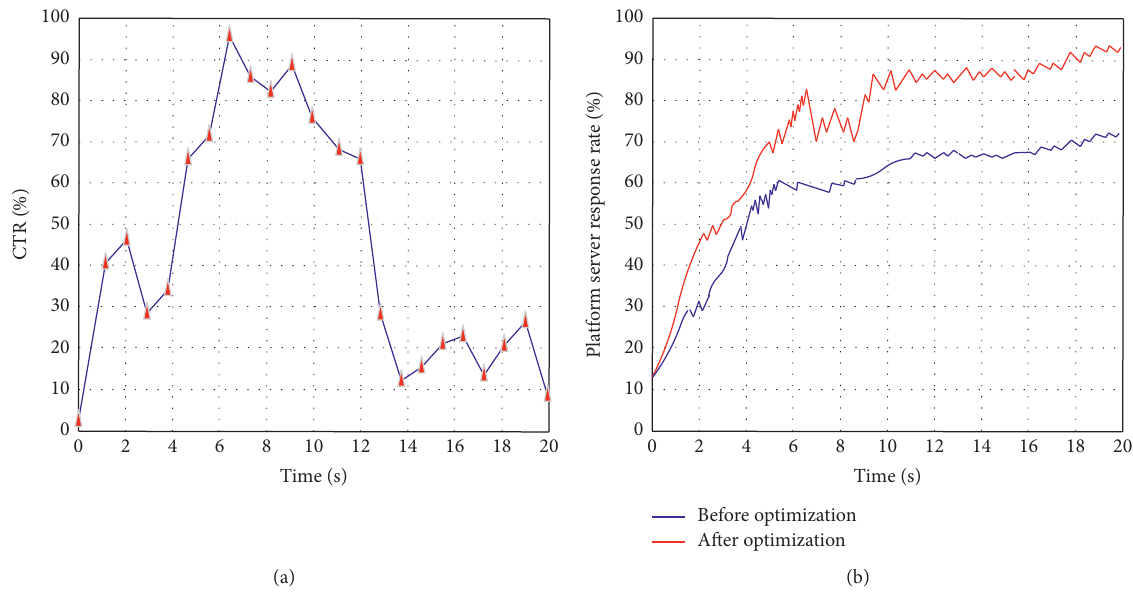
Figure 8: Server performance analysis of the public service platform: (a) the user clicks on the graph in each time period; (b) response graph of platform server before and after optimization.